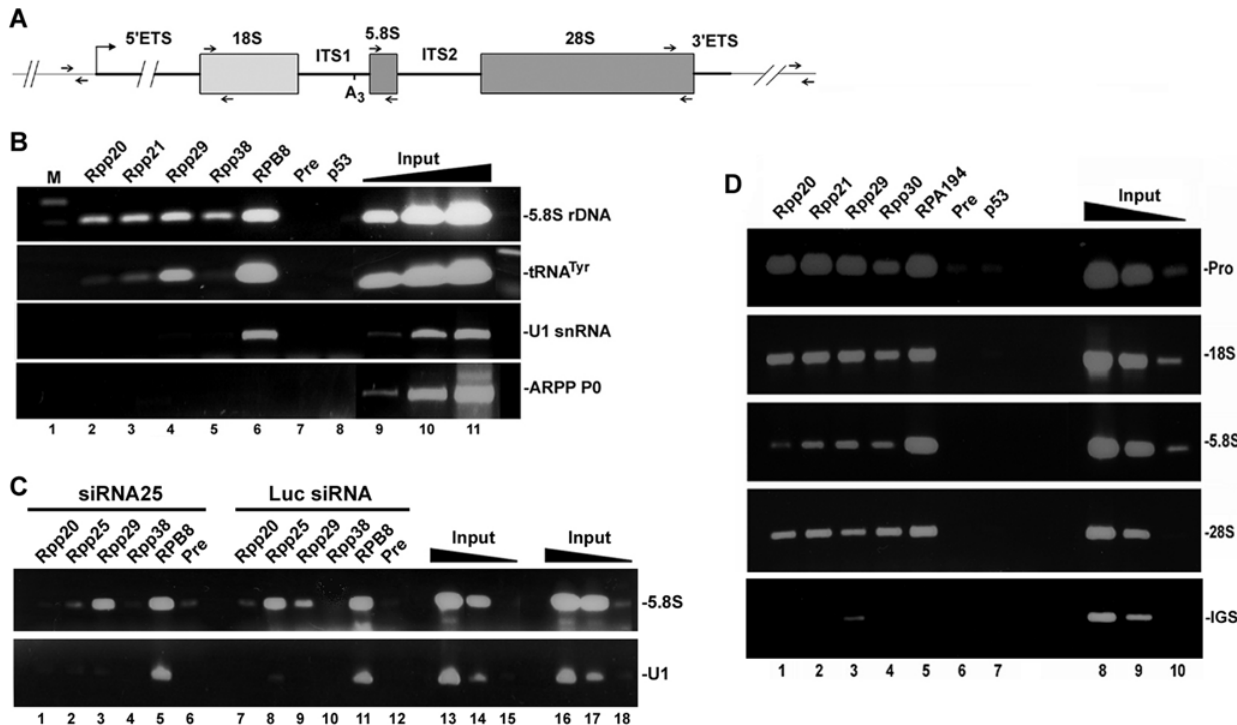
Figure 6. Protein subunits of RNase P occupy the promoter and coding region of rDNA. A. Structure of a rRNA gene, showing 18S, 5.8S and 28S rRNA flanked by 5 9 ETS and 3 9 ETS and intervened by ITS1 and ITS2. RNase MRP cleaves at the A3 site in the ITS1. Small arrows indicate locations of primers used for PCR. B. ChIP was performed with rapidly dividing HeLa cells using affinity-purified polyclonal antibodies against Rpp20 (lane 2), Rpp21 (lane 3), Rpp29 (lane 4), Rpp38 (lane 5), RPB8 (lane 6), preimmune serum (lane 7) or p53 (lane 8). DNA of the precipitated chromatin was analyzed by PCR for the presence of 5.8S rDNA, tRNA Tyr , U1 snRNA and ARPP P0 genes. Positive PCR products for each gene using 0.01, 0.1 and 1% of input DNA are shown (lanes 9–11). This panel is a composite of two mini-agarose gels with the same exposure time. C. HeLa cells were transfected with siRNA25 (lanes 1–6), which caused marked knockdown of Rpp25 (data not shown), or with control luciferase siRNA (lanes 7–12) for 48 h. ChIP analysis was then performed for 5.8S rDNA and U1 snRNA gene using antibodies against Rpp20, Rpp25, Rpp29, Rpp38, RPB8 and preimmune serum. Positive PCR reactions using 0.01, 0.1 and 1% of input DNA are shown (lanes 13–18). D. ChIP analysis was performed with cells as in B using antibodies against Rpp20 (lane 1), Rpp21 (lane 2), Rpp29 (lane 3), Rpp30 (lane 4), RPA194 (lane 5), preimmune serum (lane 6) or p53 (lane 7). DNA of the precipitated chromatin was analyzed by PCR for the presence of the promoter, 18S, 5.8S, 28S or IGS DNA using the corresponding primers shown in A. Positive PCR reactions for each rDNA region using 0.01, 0.1 and 1% of input DNA are shown (lanes